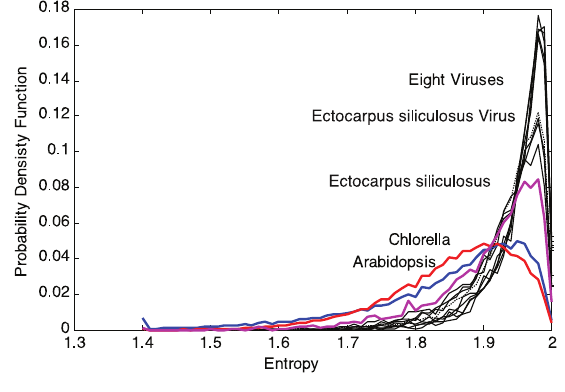
Figure 2. Plot of the probability density function (pdf) of the entropy for 8 plant viral genomes (AR158, ATCV, CVM1, FR483, MR325, NY2A, PBCV1, TN603), Arabidopsis thaliana , Chlorella NC64A, Ectocarpus siliculosus and EsV-1. The plots were obtained for a block size of B =